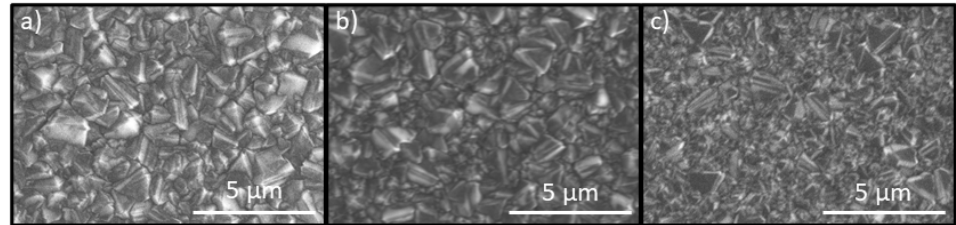
Figure 2. SEM images of BDD films deposited at different [B]/[C] ratios in plasma, namely, ( a ) 500 ppm, ( b ) 10,000 ppm, and ( c ) 15,000 ppm. Magnification of 10,000×. Additionally, the Fano-shaped peaks located at ca. 500 cm − 1 (BWF function #1), 1200 cm − 1 (BWF function #2), and 1332, 1317, and 1310 cm − 1 (BWF function #3) were modelled using the Breit–Wigner–Fano function (see Equation (6)) [47] which is shown in Figure 3a–c insets.